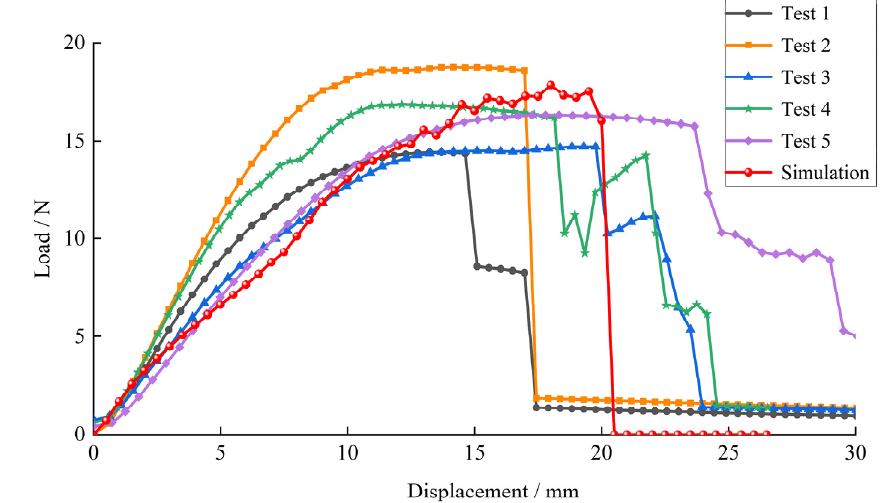
Figure 13. Displacement–force variation curve of rape stems under three-point